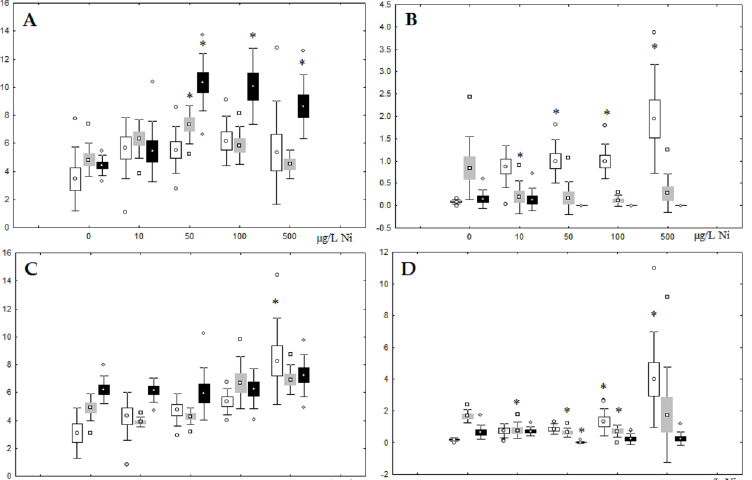
Figure 2. Content (% dry weight) of ( A ) phospholipids, ( B ) triacylglycerols, ( C ) cholesterol, and ( D ) cholesterol esters in the digestive glands of A. cygnea under experimental nickel effects: white box – day 1 of the experiment; grey box – day 3 of the experiment; black box – day 7 of the experiment. * – significant results in comparison with control (0 µg/L Ni). Differences were estimated using the nonparametric Kruskal – Wallis test; p < 0.05.